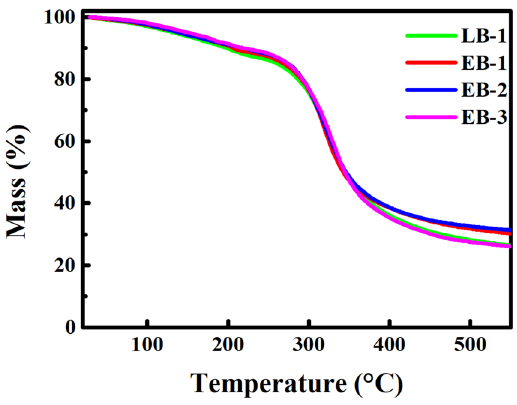
Figure 5: Thermogravimetric curves of the gelatin samples. Figure 6: Foaming stability of the gelatin